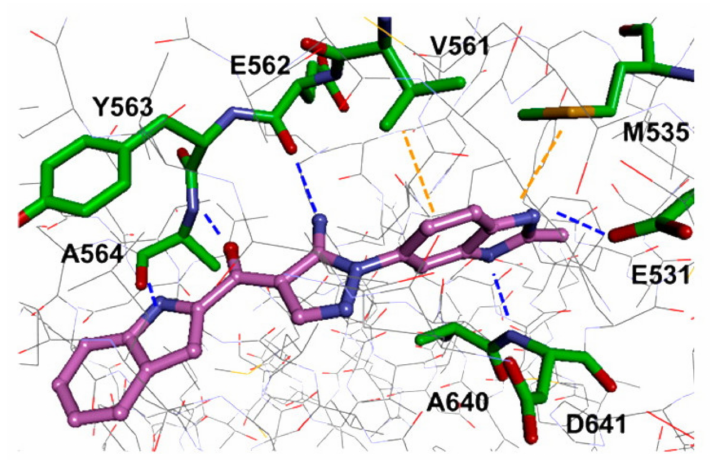
Figure 35. Putative binding mode of compound 31 with FGFR1 crystal structure